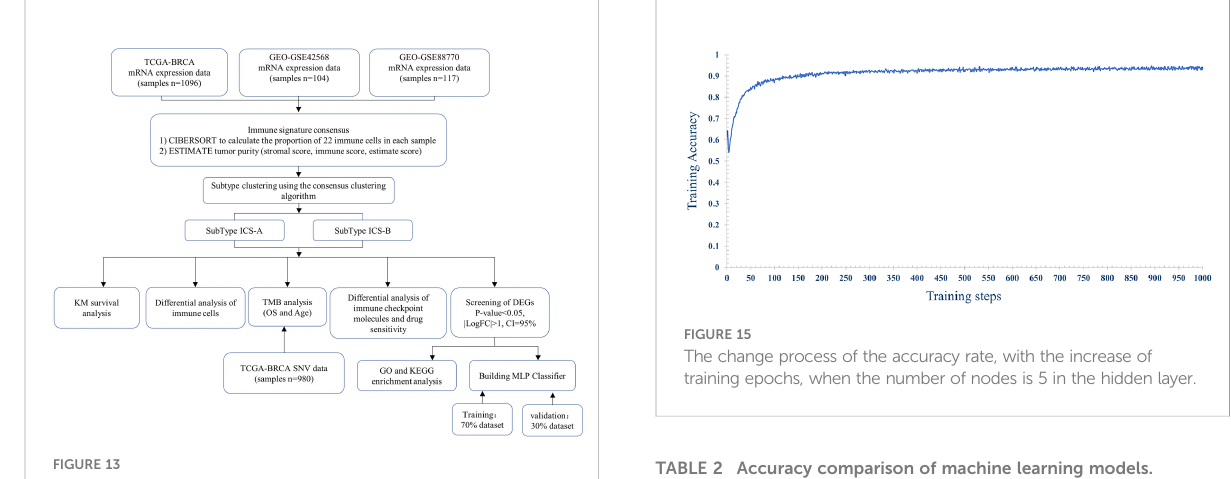
TABLE 2 Accuracy comparison of machine learning